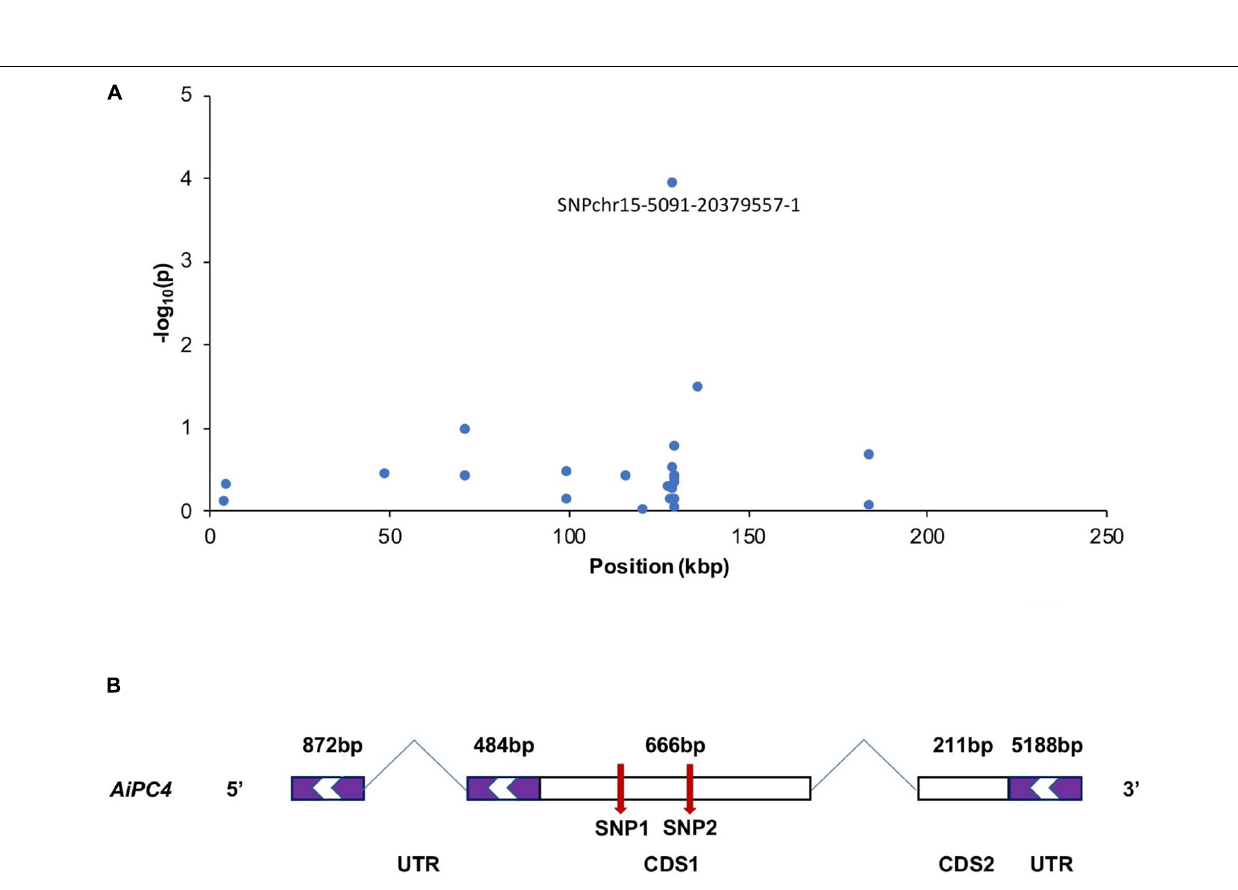
Frontiers in Genetics |